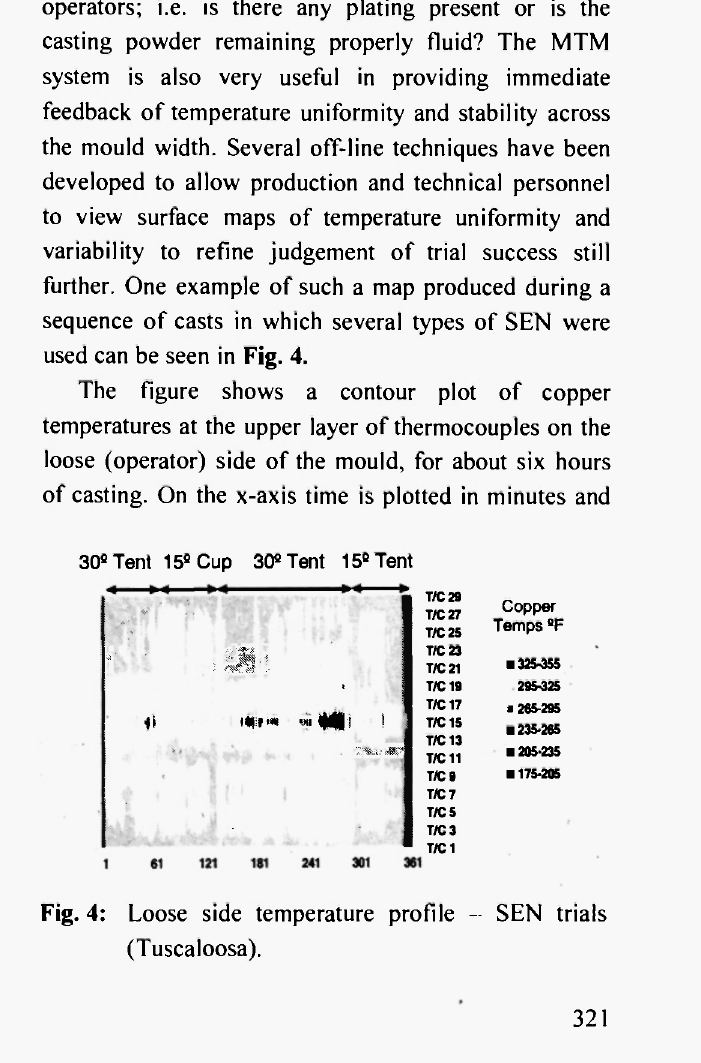
Fig. 4: Loose side temperature profile - SEN trials